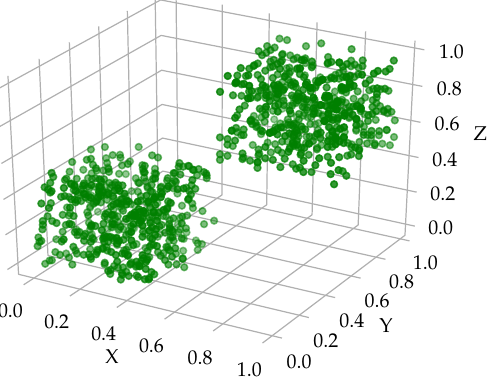
Figure 14. Input vector clusters.